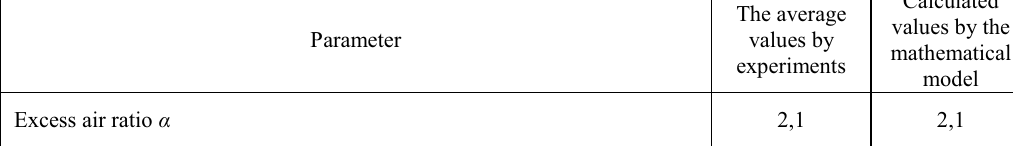
Calculated The average values by the values by mathematical experiments model 3,8